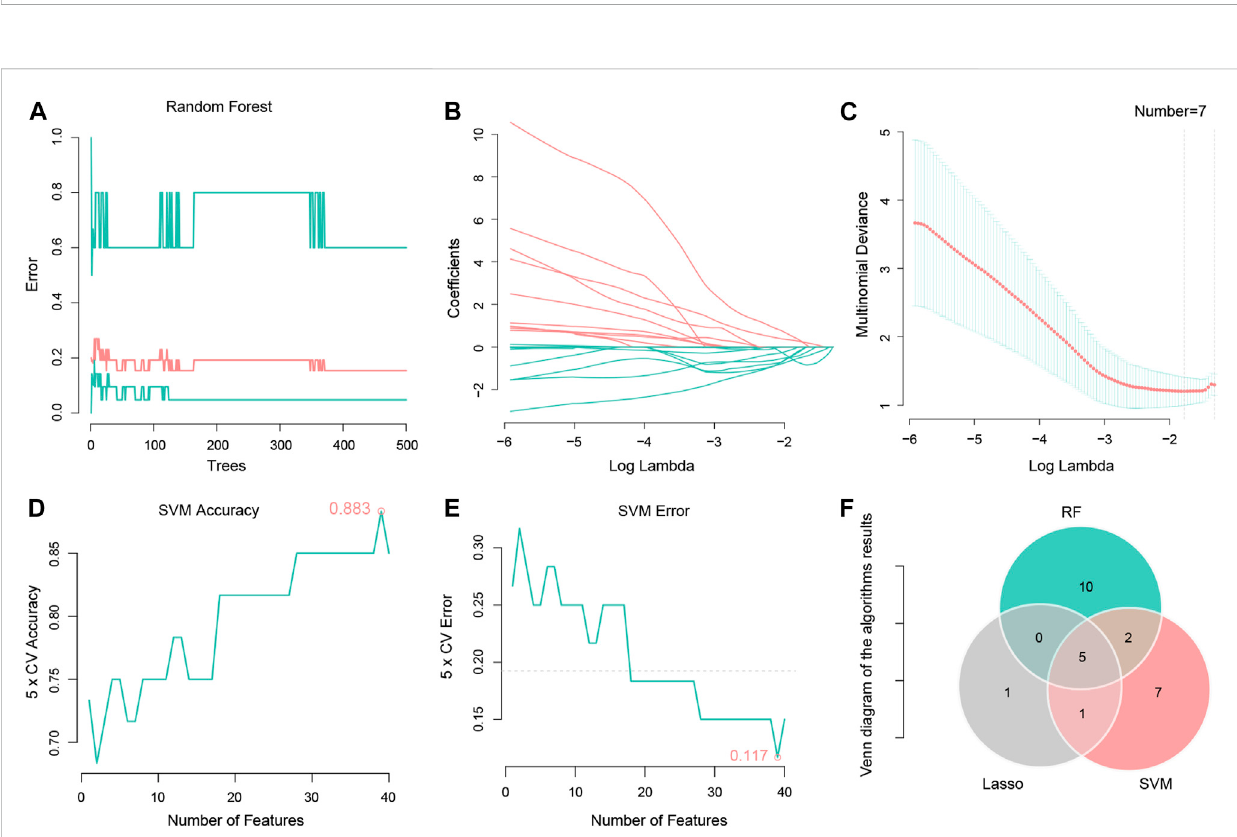
Using Random forest, Lasso regression and SVM algorithms to identify fi ve chemotherapy related LncRNAs. (A) Random forest tree model, the number of random forest trees is set to 500 (horizontal coordinate). The vertical coordinate represents the cross validation error. The bottom green line represents the error of the control group, the red line represents the error of all the samples, and the top green line represents the error of the experimentalgroup. (B) LASSOregressionofthe7genes. (C) Theabscissarepresentslog λ ,andtheordinaterepresentsthecrossvalidationerror.The point withtheleastvalidation errorcorrespondsto 7genes. (D) Agraph representing theaccuracyof theSVM.The fi gure shows an accuracy of0.883. (E) Graph representing SVM cross validation error, using 5X cross validation, error shown in the fi gure is 0.117. (F) Venny diagram shows 5 intersection genes of the 3 algorithms, respectively LINC01857, AC064836.3, CAHM, AL691432.1, and